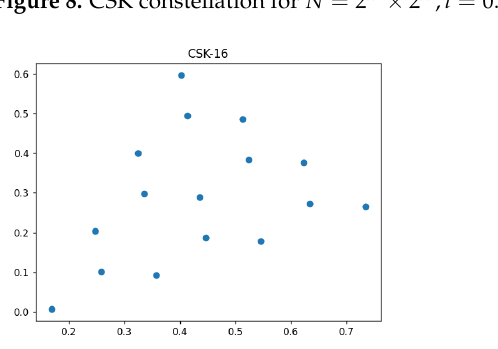
Figure 8. CSK constellation for N = 2 2 i × 2 2 i , i = 0.